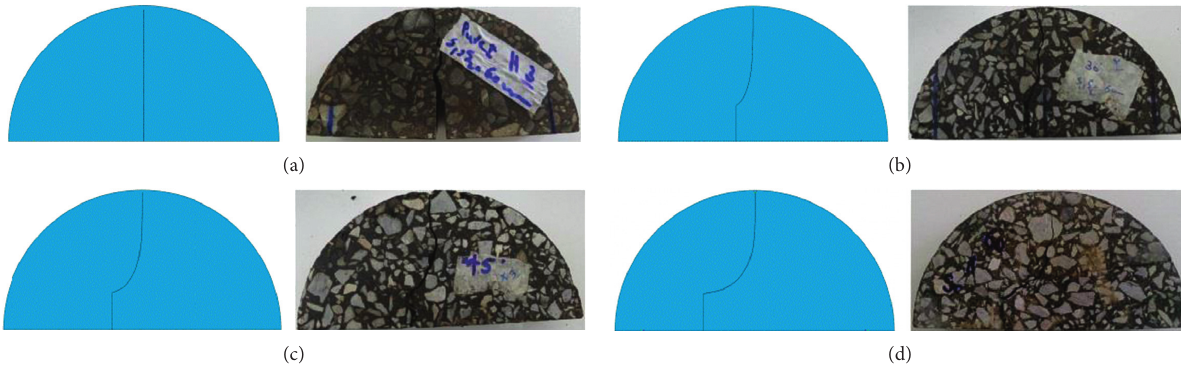
v in the SCB specimen.